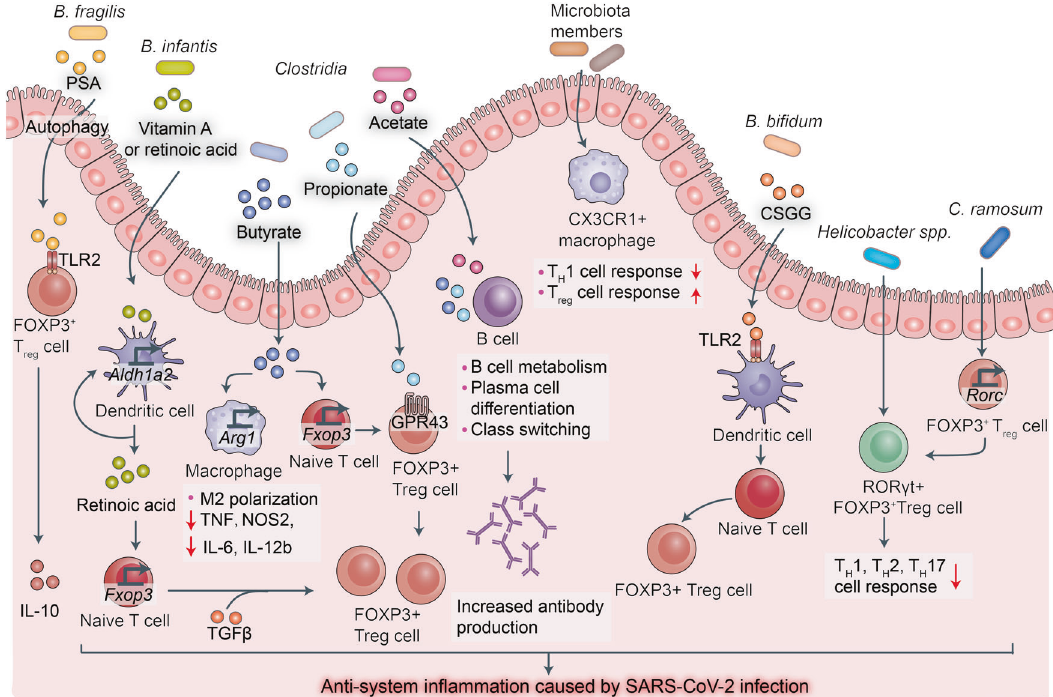
Fig. 6 Anti-in fl ammatory immunomodulation by gut microbiota-derived metabolites and components. Left to right: polysaccharide A (PSA) capsular component of gut commensal Bacteroides fragilis can be transported to gut lamina propria via autophagy-related protein 16-like 1 (ATG16L1) and nucleotide-binding oligomerization domain-containing protein 2 (NOD2)-dependent autophagy. PSA signals promote FOXP3 + regulatory T-cell (Treg) proliferation and IL-10 production and induce an anti-in fl ammatory state. Vitamin A or retinoic acid (RA) derived from gut commensal Bi fi dobacterium infantis upregulates Aldh1a2 encoding retinal dehydrogenase 2 in DCs. Aldh1a2 -expressing DCs produce high levels of RA which collaborates with transforming growth factor- β (TGF- β ) to promote naive T cell differentiation into FOXP3 + Treg cells and inhibit in fl ammation caused by SARS-CoV-2 infection. Gut microbiota may produce short-chain fatty acids (SCFAs) acetate, propionate, and butyrate to inhibit in fl ammation caused by SARS-CoV-2 infection. Butyrate promotes M2-like macrophage polarization and anti-in fl ammatory activity by upregulating arginase 1 (ARG1), suppressing tumor necrosis factor (TNF) production, and downregulating Nos2, Il6 , and Il12b . Butyrate inhibits histone deacetylases, increases transcription at Foxp3 promoter and related enhancer sites in naive T cells, and promotes naive T cell differentiation into Treg cells. Propionate activates GPR43 on Treg cells, thereby enhancing their proliferation. Acetate promotes anti-SARS-CoV-2 antibody production in B cells, thereby inhibiting SARS-CoV-2 infection. Microbiota members induce CX3CR1 + macrophages that inhibit T helper 1 (TH1) and promote Treg cell responses. Cell-surface β -glucan/galactan (CSGG) polysaccharide produced by Bi fi dobacterium bi fi dum may induce Foxp3 + regulatory T-cell generation and inhibit in fl ammation caused by SARS-CoV-2 infection. Gut commensals such as Helicobacter spp. and Clostridium ramosum induce ROR γ t expression in Foxp3 + regulatory T cells, thereby suppressing TH1, TH2, and TH17 cell-type in fl ammatory